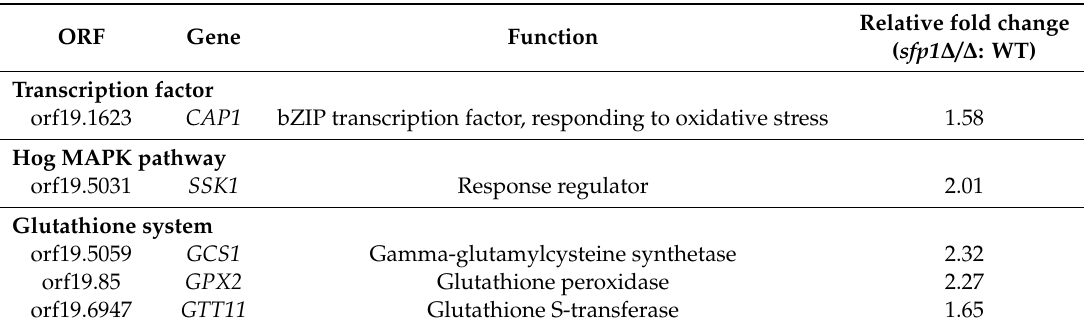
Table 1. Relative expression of oxidative stress response genes in the sfp1 -deleted vs wild-type strains. ( P <